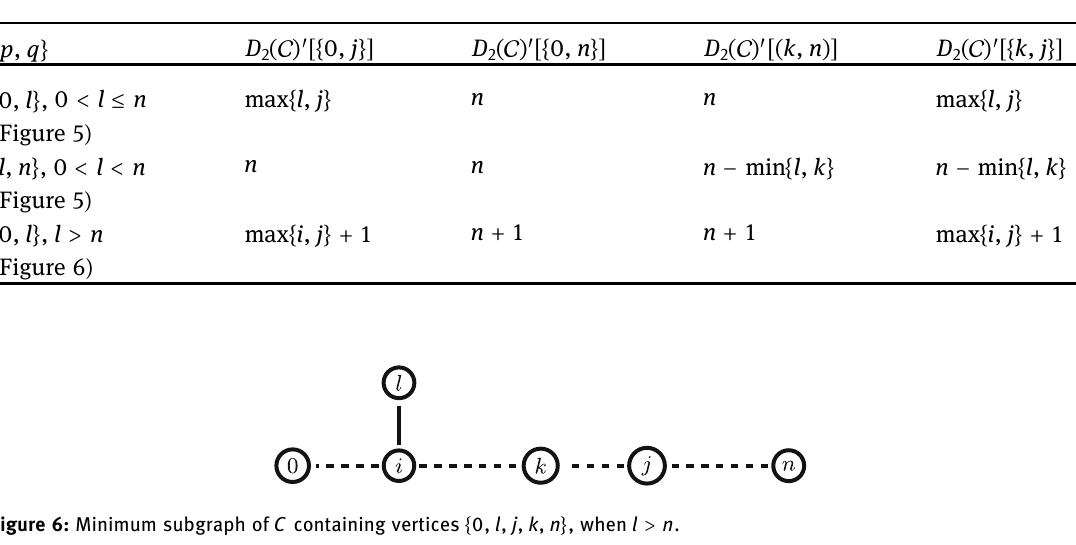
Figure 7: Minimum subgraph of C containing vertices